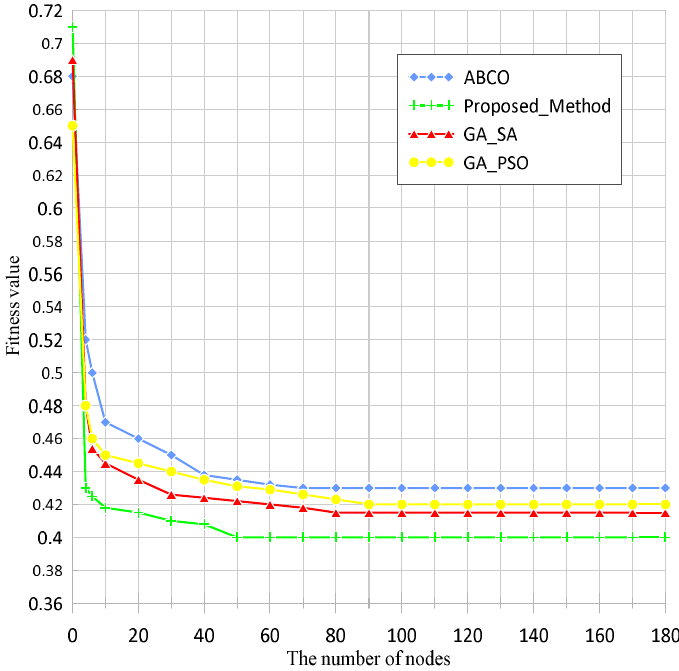
Figure 4. Convergence diagram of the fitness function for the proposed algorithm.